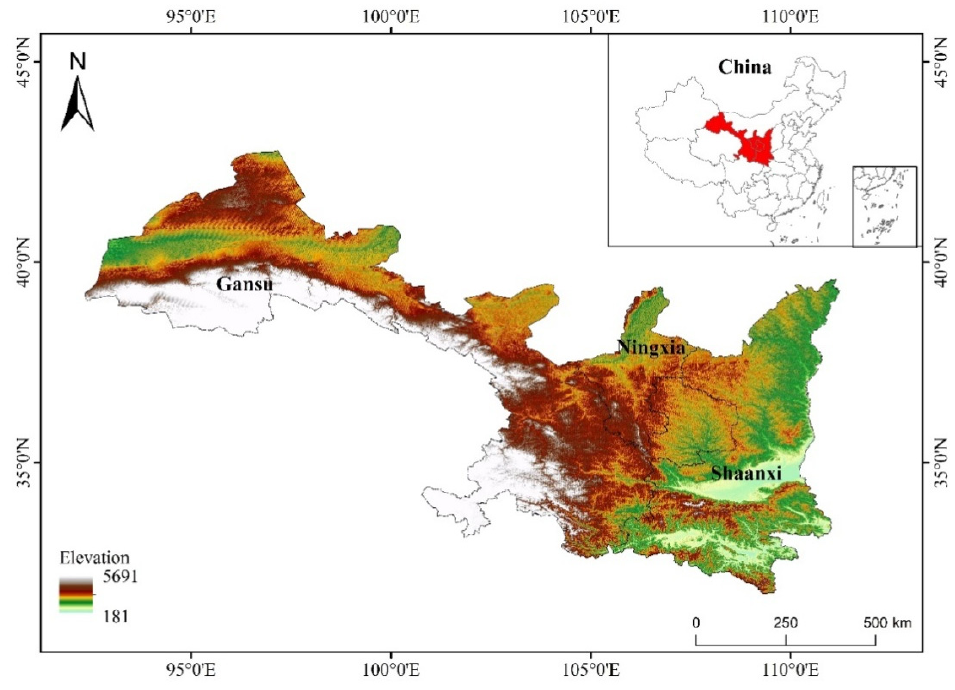
Figure 2. Map of study area (Source: Arc GIS 10).